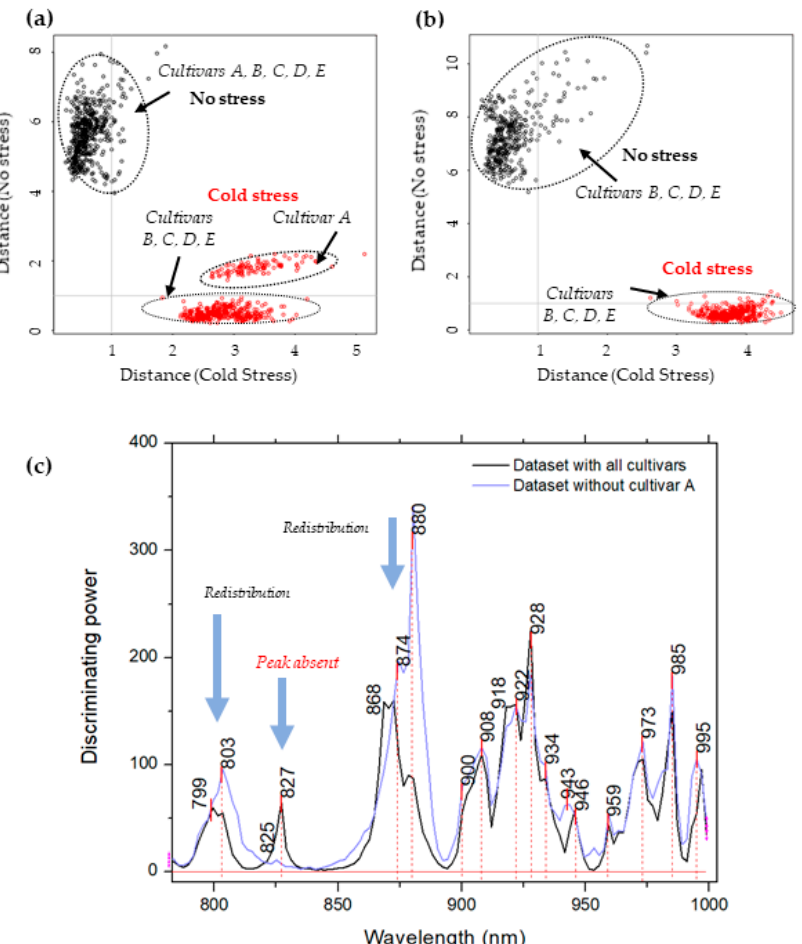
Figure 3. ( a ) SIMCA analysis results when modeling was performed using the dataset with all cultivars (A, B, C, D and E). Cooman’s plot of plants grown in normal conditions (27 ◦ C) (black) and plants exposed to mild cold stress for one week (22 ◦ C) (red) shows excellent separation between plants and reveals distinctive stress response in cultivar A; ( b ) SIMCA analysis results when modeling was performed after the spectra of cultivar A were excluded from the analysis. Cooman’s plot of plants grown in normal conditions (black) and plants exposed to mild cold stress for one week (red) shows strong, reliable separation of classes without distinction of cultivars within the class; ( c ) discriminating powers of SIMCA analyses. Comparison of discriminating powers shows that in both cases almost the same wavelengths contributed to the successful separation of classes of plants grown at normal temperature and in cold stress conditions. The exception is a peak at 827 nm, which is missing in the discriminatory power of SIMCA performed on the dataset without cultivar A.